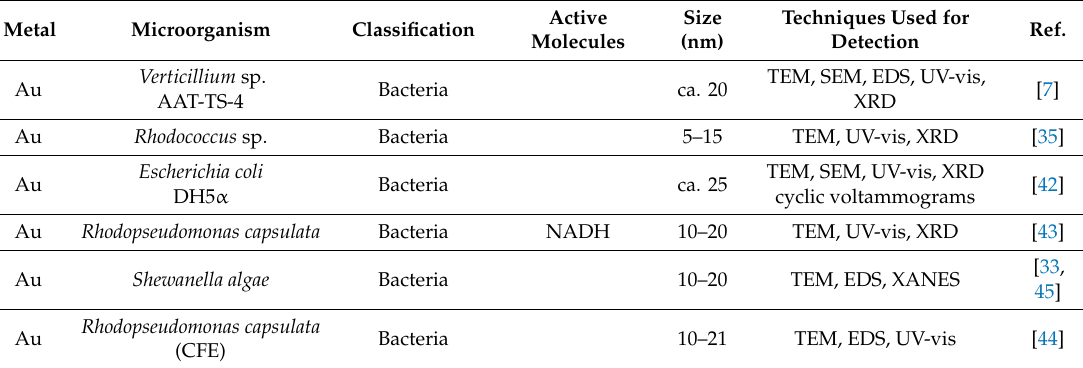
Table 2. List of microorganisms for synthesis of Au nanoparticles and technique for confirmation of Au